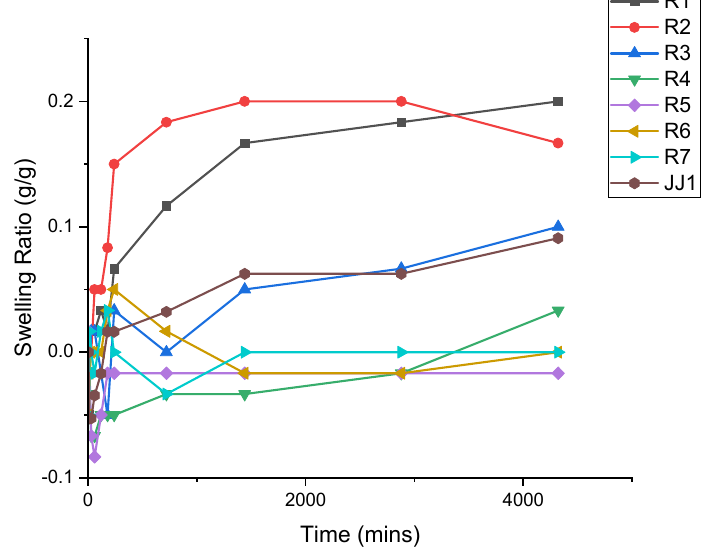
Figure 4. Demonstrating the swelling ratios (g/g) for NMIP samples over a period of three days. The y -axis demonstrates the swelling ratio, which is compared to the x -axis in units of minutes.